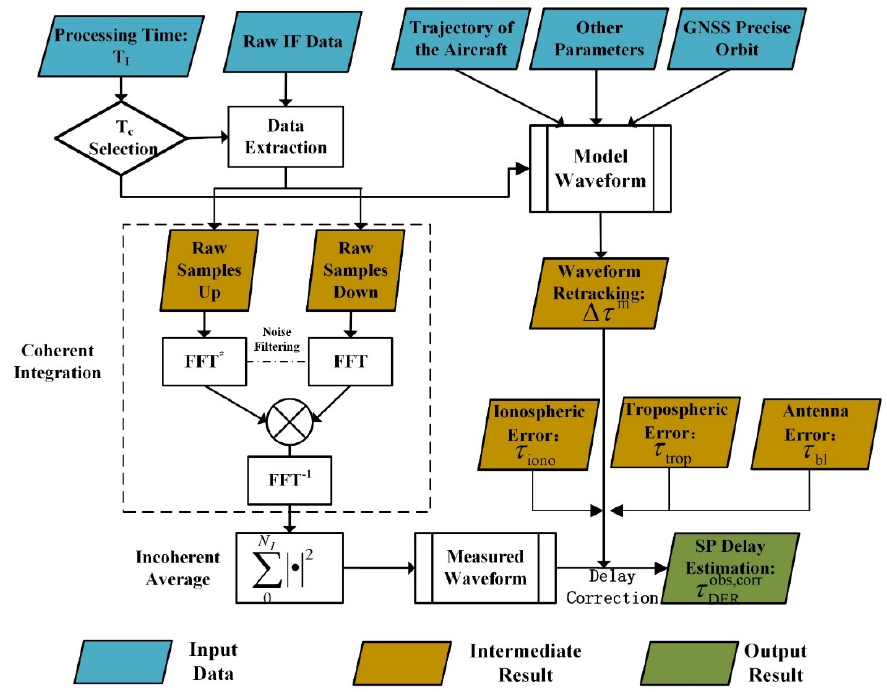
Figure 1. Simplified flowchart of airborne IF data processing.